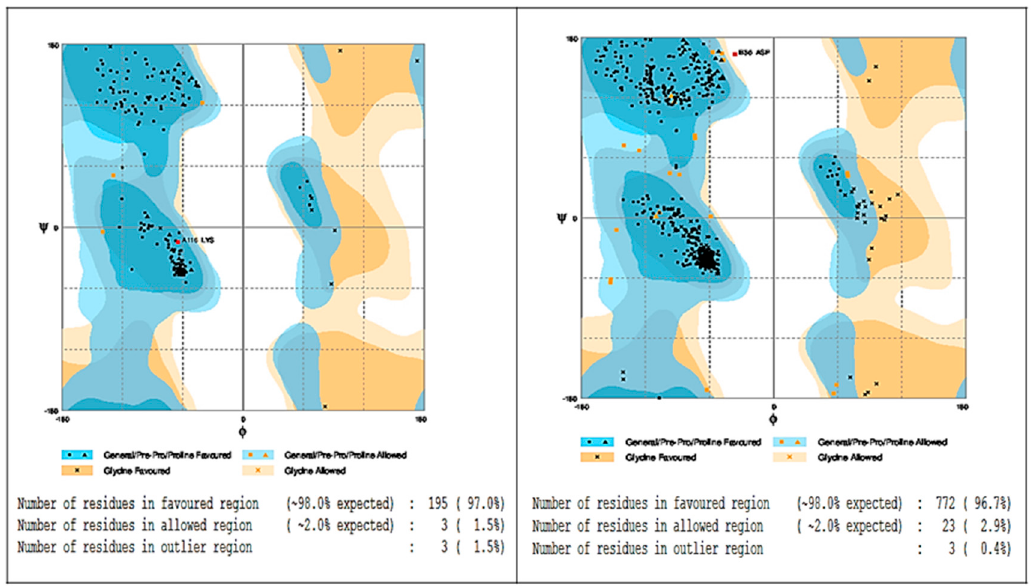
Figure 3. Ramachandran plot analysis: homology models of alanine aminotransferase (ALT, left ) and